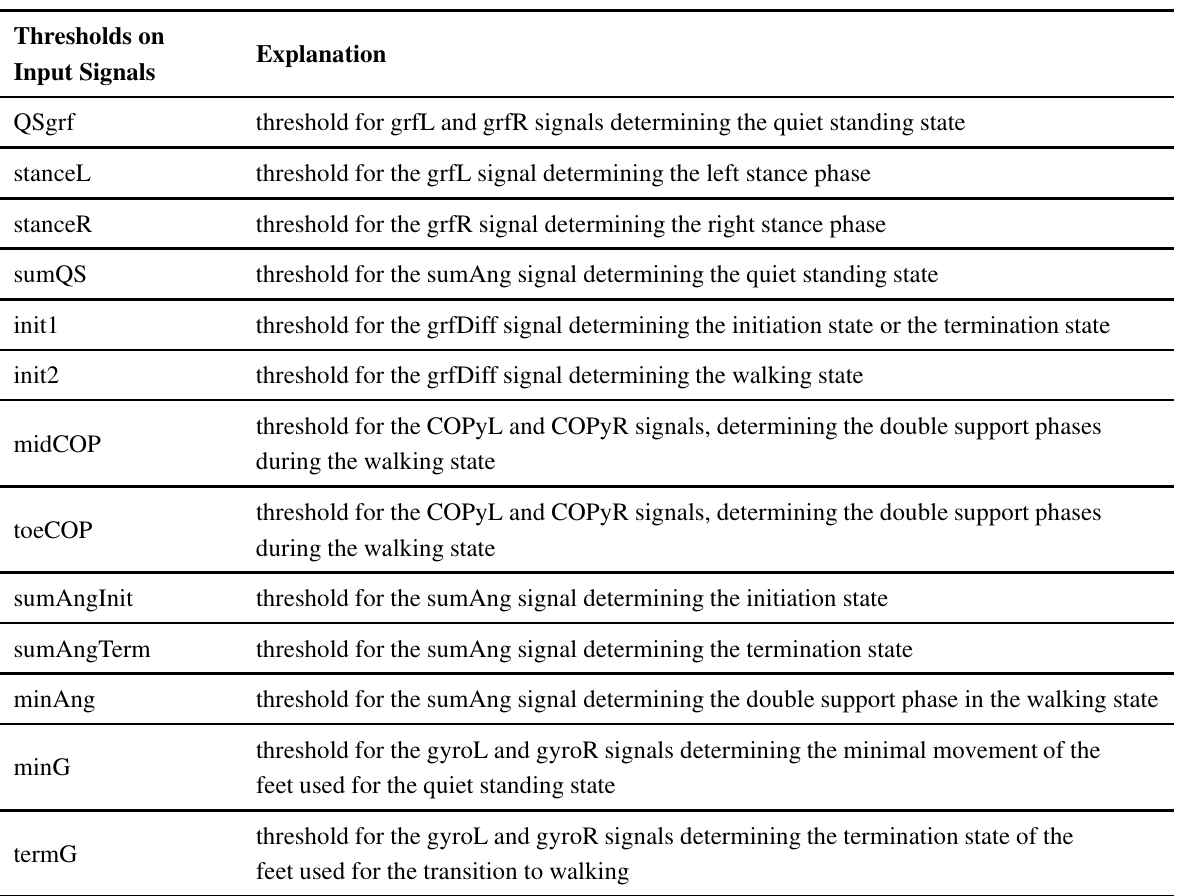
Table 2. Thresholds defined for the input signals from Table 1. The left column consists of threshold tags and the right column the corresponding